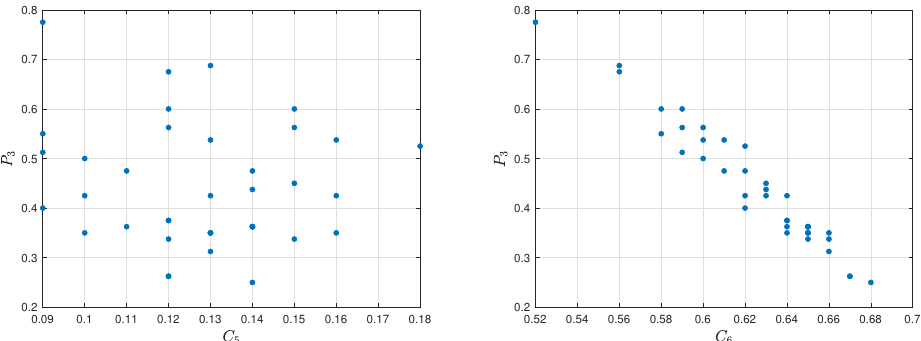
Figure A2. The relation diagram of Average assists per round ( C 5 ) for assessment P 3 ( left side ) and Average deaths per round ( C 6 ) for assessment P 3 ( right side